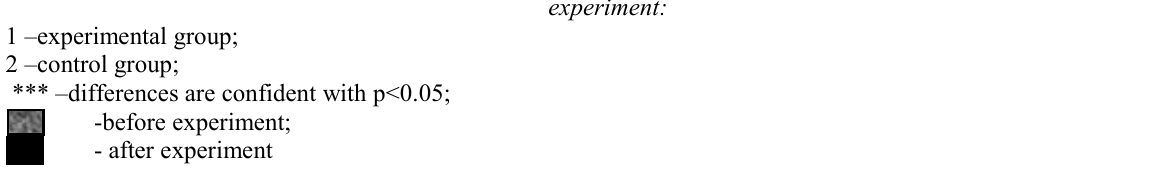
Fig. 4. Results of test “1000 meters’ run” of experimental (n=33) and control (n=34) groups before and after